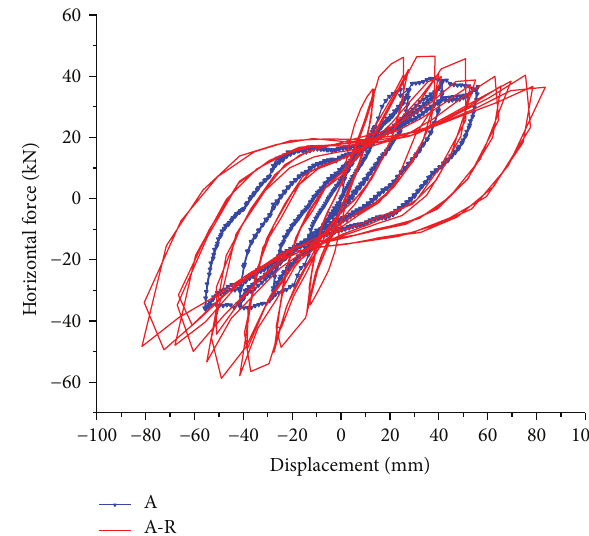
Figure 6: Comparisons of the hysteretic curves of original speci- mens.